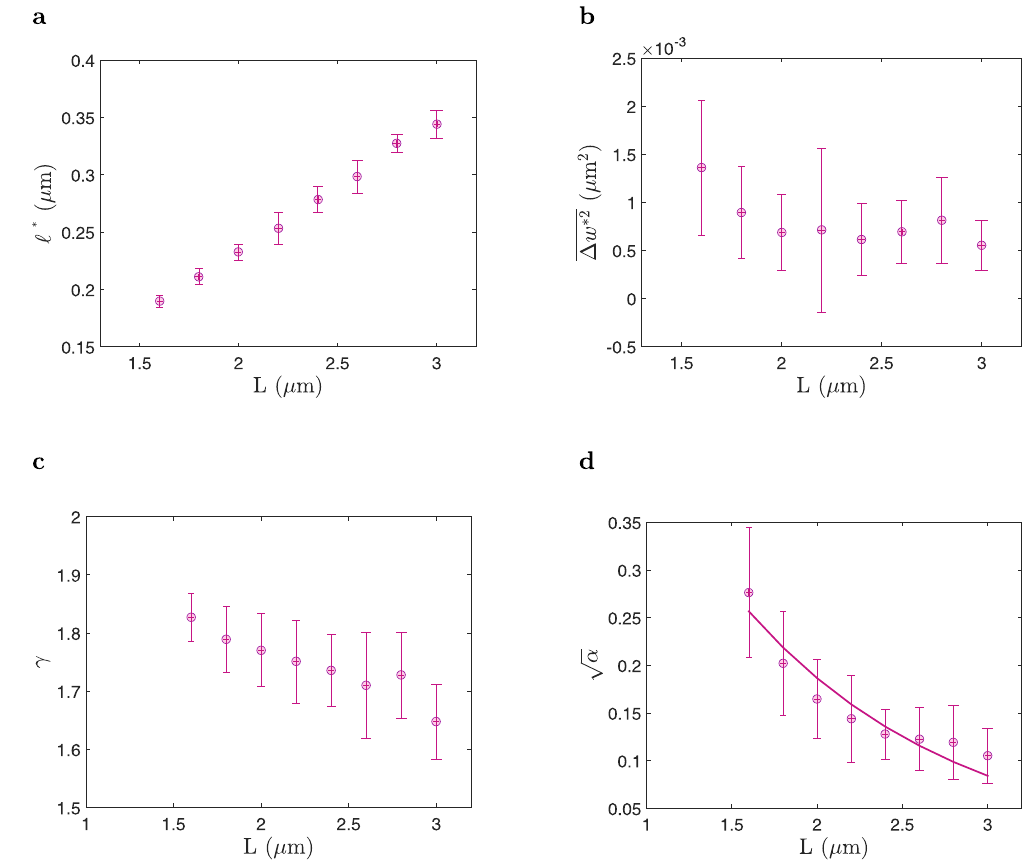
Figure 3. Characterization of multi-domain morphological structures based on the length of E . coli cells. Data of panels are from 417 cells (Table 1) with different lengths L , and are expressed as mean ± standard error of mean. ( a ) Length of the domains  ⁎ (starting point of the regime II), based on the length of cells. ( b ) MSWD of the local-cell-width in a domain ∆ ⁎ w 2 (starting point of the regime II), based on the length of cells. ( c ) Exponent of the fitted polynomial function γ ( α = γ  MSWD ), to the first 20 points based on the length of cells. ( d ) Coupling constant α ( α = γ  MSWD ), based on the length of cells. The error bars indicate the standard error of mean of each